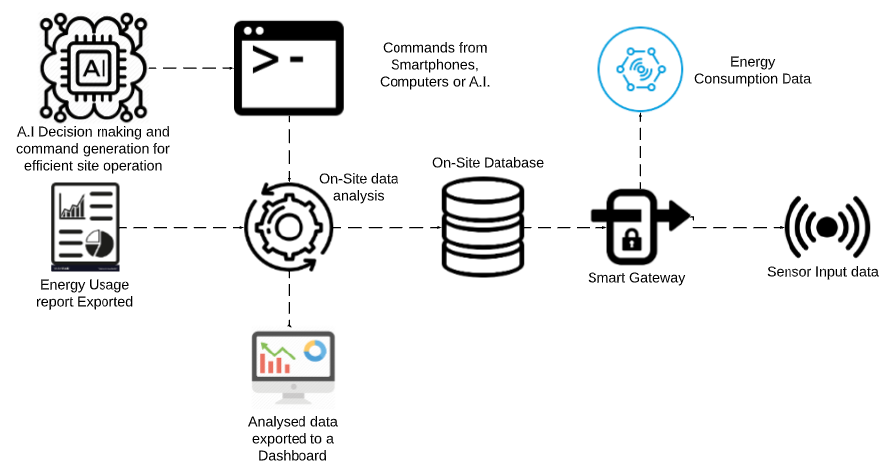
Figure 2. Data collection and analysis.